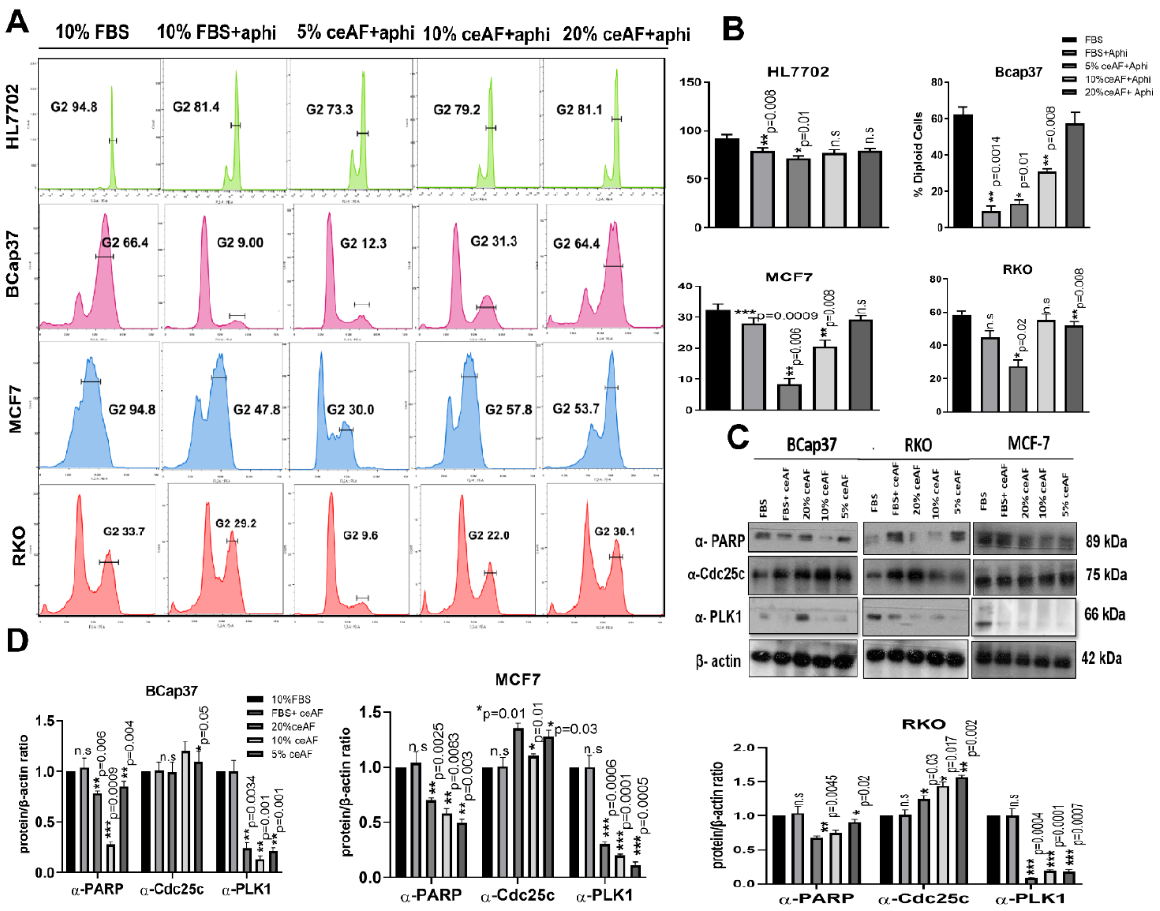
Figure 2. ceAF works agonistically with aphidicolin to arrest tumor cell metastasis. ( A ) Role of ceAF in suppressing growing tumor cells transition in cell cycle via arresting at G1 phase using aphidicolin. Cells were treated with different fractions, 20, 10, and 5% ( v / v ) of ceAF, and later treated with a reversible inhibitor of DNA aphidicolin. Flow cytometry measured DNA content by tracing cells’ fluorescence intensity. The percentage of diploid cells is shown on the right side ( B ), whereas the HL7702 cell line was used as usual. ( C ) Immunoblots showing significant upregulation of proteins regulating cell cycle and apoptosis (Figures S1–S3). In contrast, β -actin is used as an internal control. Quantification of protein bands was performed by densitometry, and the relative gene/actin ratio is shown in the bottom panel ( D ). The results shown here are representative of at least three independent experiments. The semi-quantitative analysis of blots is shown were Student’s t -test obtained mean ± SD * p < 0.05 and ** p < 0.01 and *** p < 0.001.